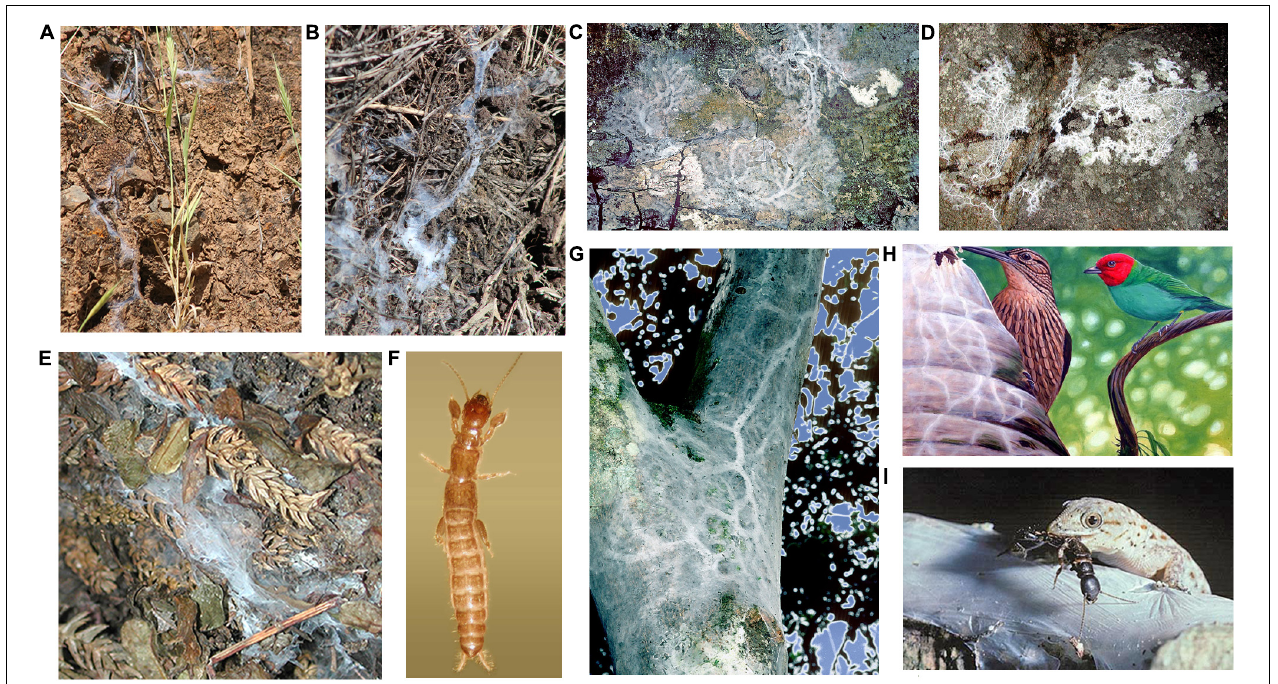
FIGURE 2 | Variation in silk domiciles and habitat for webspinners and potential predators of Antipaluria urichi of Trinidad. (A) Haploembia tarsalis and (B) H. solieri silk in California. (C) Pararhagadochir trinitatis silk in Trinidad. (D) Notoligotoma hardyi silk on granite outcrop on Magnetic Island. (E) Metoligotoma incompta silk on Magnetic Island, Queensland. (F) H. tarsalis adult female (1.0 cm in length). (G) A. urichi silk in Trinidad showing thick silk typical of an egg-guarding female. (H) Bay-headed Tanager and Woodcreeper, two birds seen tearing into Antipaluria urichi silk. (I) Gecko preying upon adult female of A. urichi caught outside of her silk. For scale, the webspinner is approximately 1.7 cm in length. Photographs by the author; painting of bird predation by Edward C. Rooks.